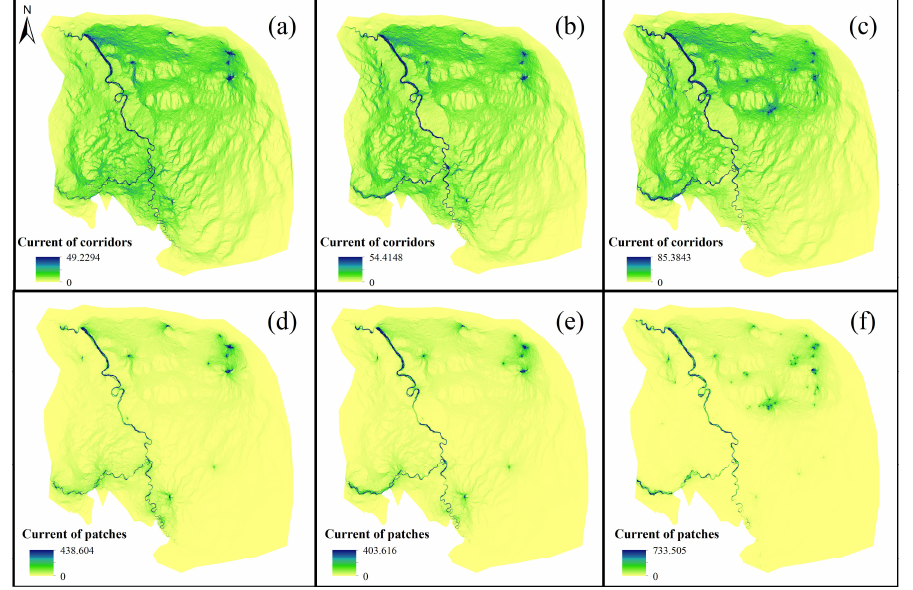
Figure 6. Current distribution maps for the Zoig ê area from 2000 to 2019. ( a ) Current of corridors in 2000, ( b ) Current of corridors in 2010, ( c ) Current of corridors in 2019, ( d ) Current of patches for 2000, ( e ) Current of patches for 2010, and ( f ) Current for patches in